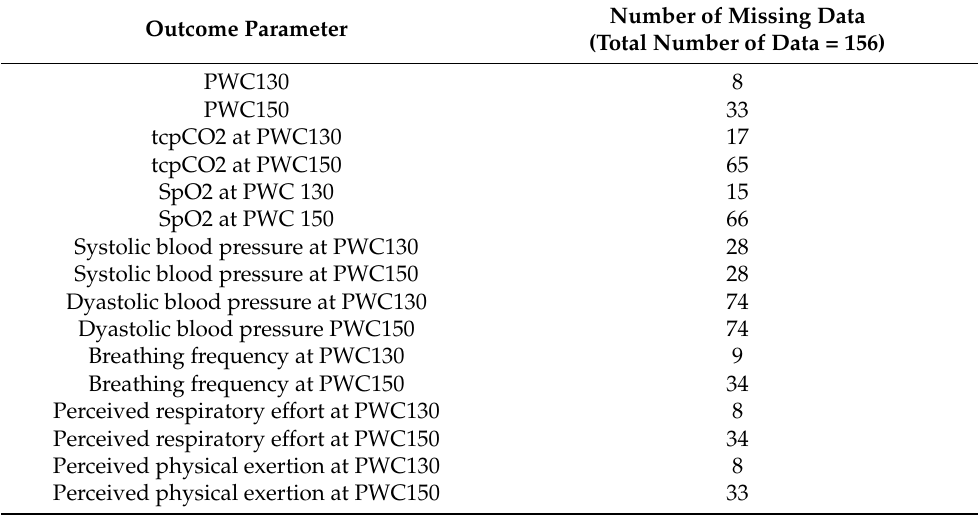
Table A3. Missing data per outcome parameter.